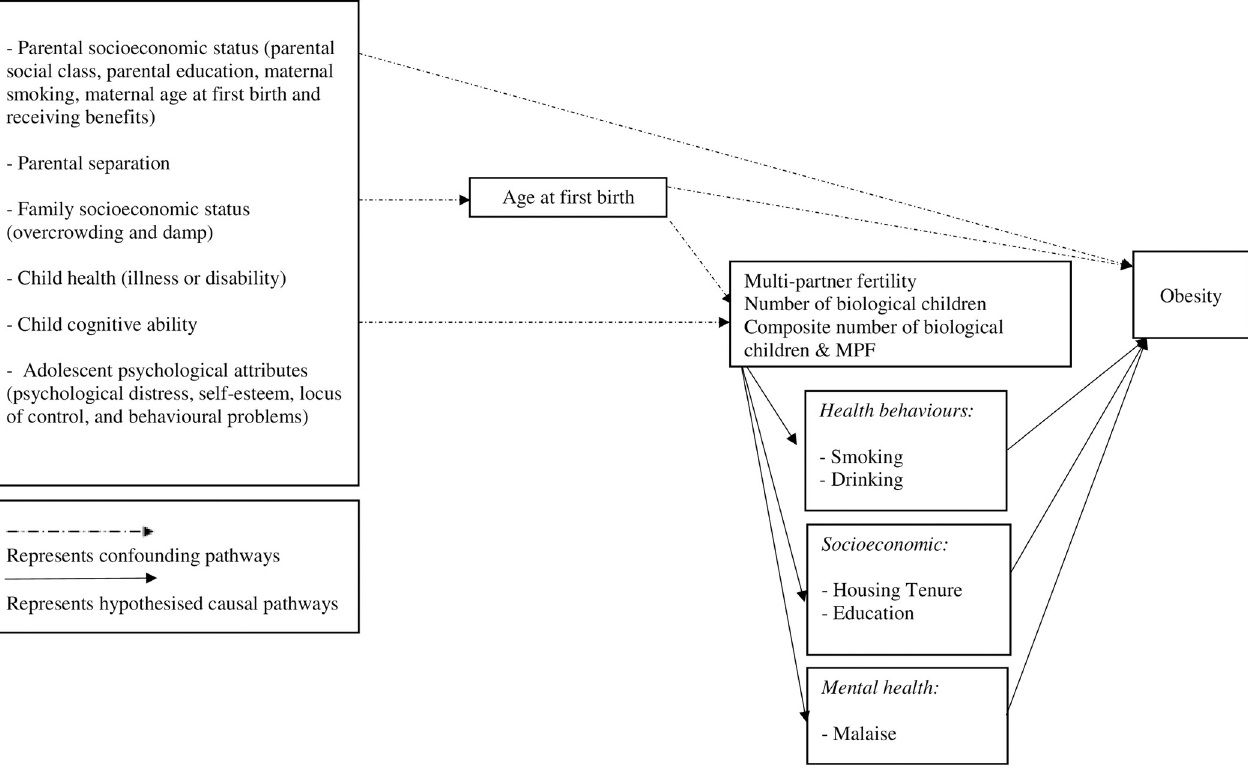
Fig 1. Conceptual diagram showing the relationship between number of children, multi-partner fertility and a composite number of biological children- MPF variable and obesity risk.